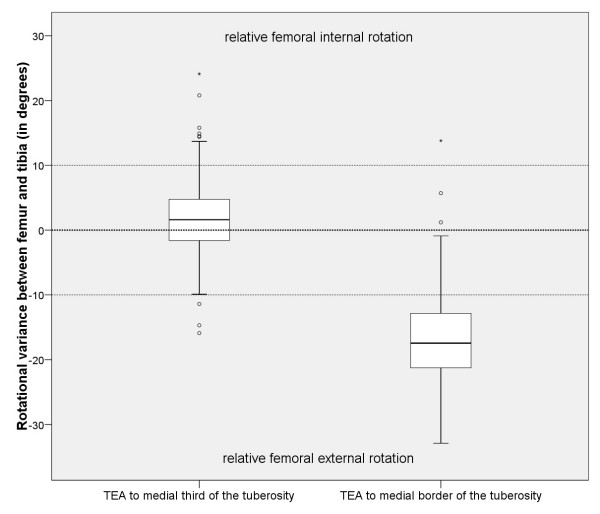
"True" rotational variance between femur (transepicondylar axis) and different tibial landmarks (medial third or medial border of the tuberosity). (Negative values indicate femoral external rotation relative to the tibia, positive values indicate relative femoral internal rotation; Box plot horizontals indicate medians and quartiles, verticals indicate minumum and maximum observations. Circles and asterixes indicate statistical outliers).